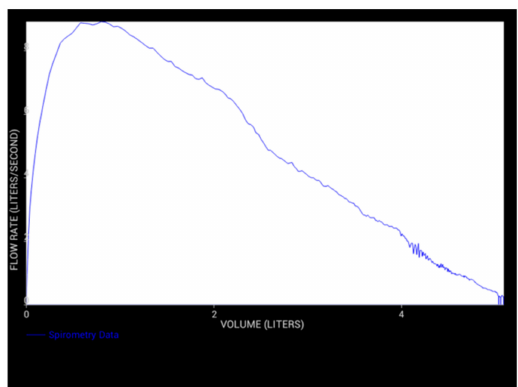
Figure 2. Typical exhalation limb of the flow-volume loop tracing produced by the novel spirometer.